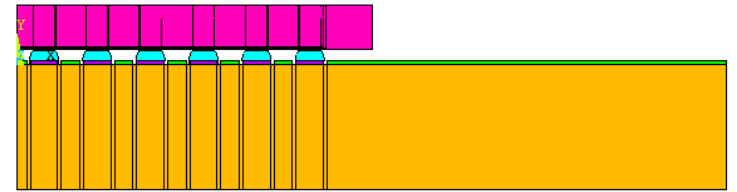
Figure 3. WLP-3 semi-diagonal FEA model.